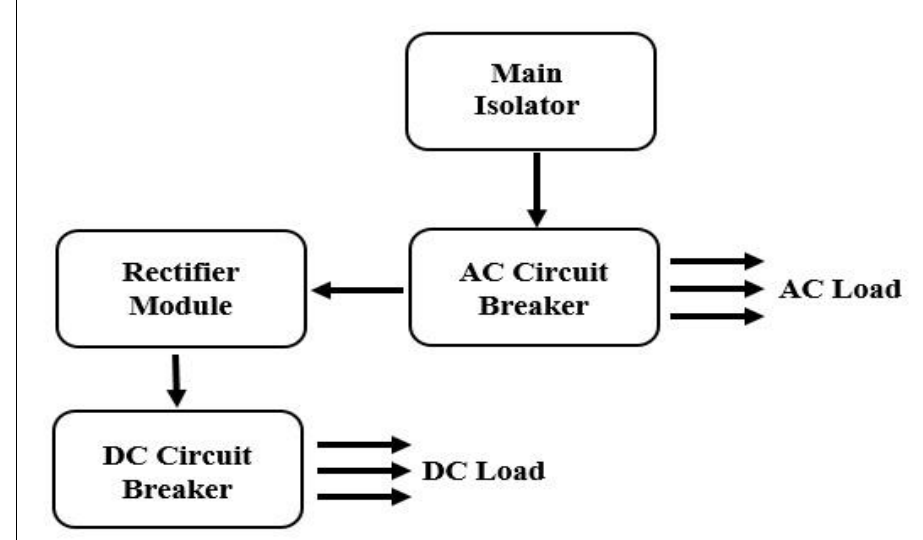
Figure 1: Block Diagram of Hybrid Distribution